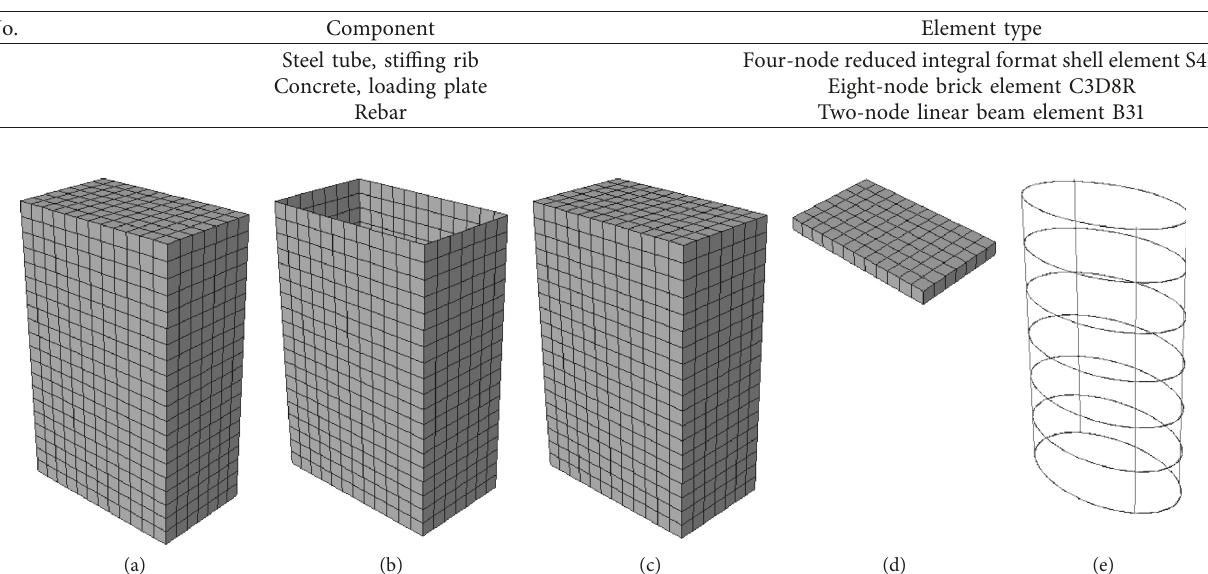
Figure 6: Comparison of the DI Table 3: Element type of the CFT component.